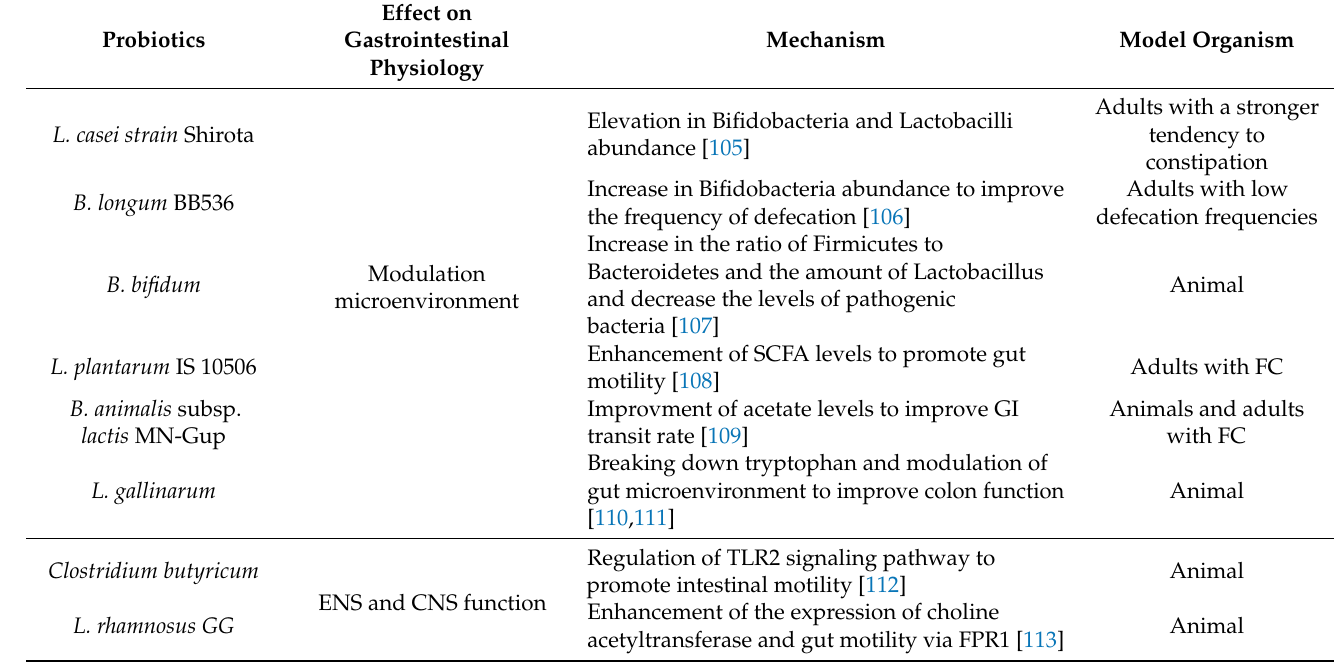
Table 3. Summary of currently known probiotics and their role in gastrointestinal